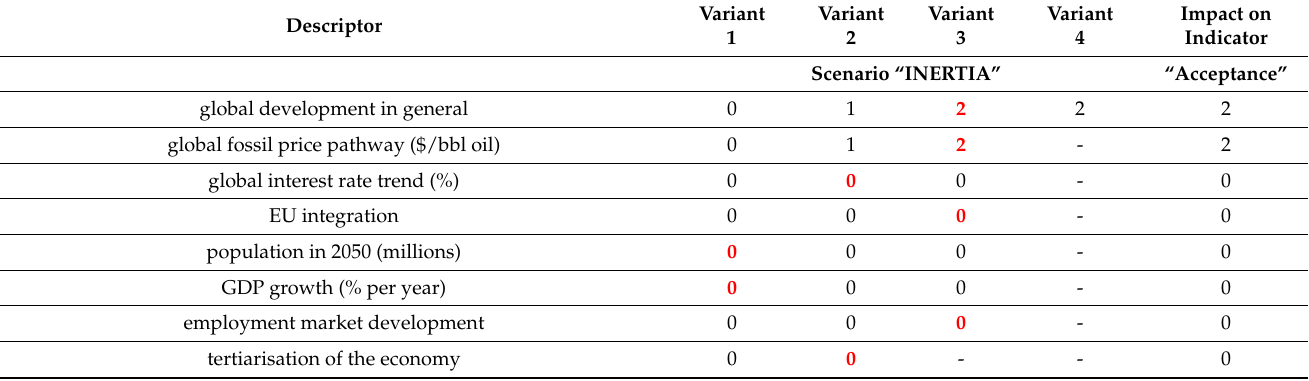
Table 3. List of descriptor impacts on the indicator “Acceptance” for the scenario